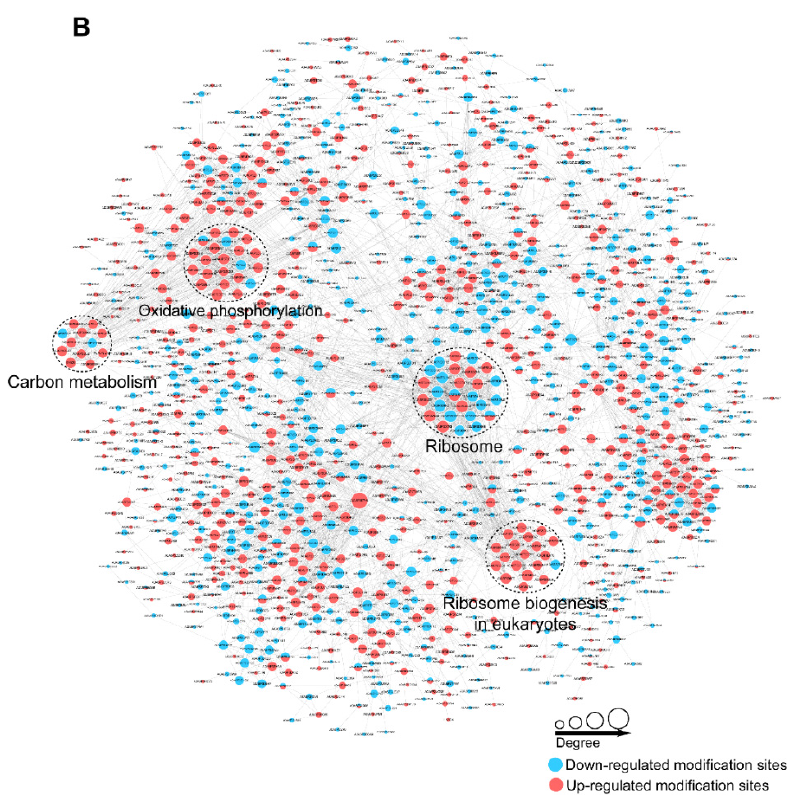
Figure 6. Protein–protein interaction networks of DEPs ( A ) and DEPPs ( B ) between PD/D.